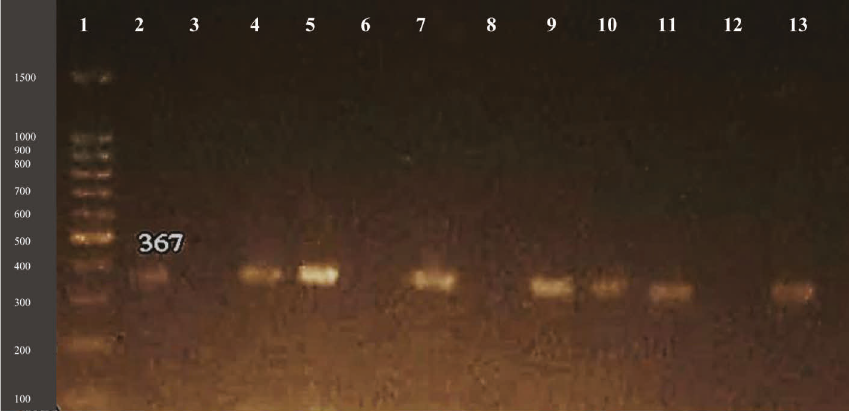
Figure 5: Molecular detection of dfrA1 gene (367 bp). Number 1: 100bp DNA ladder; number 2: positive control; number 3, 6, 8, 12: negative samples; number 4, 5, 7, 9, 10, 11, 13: positive